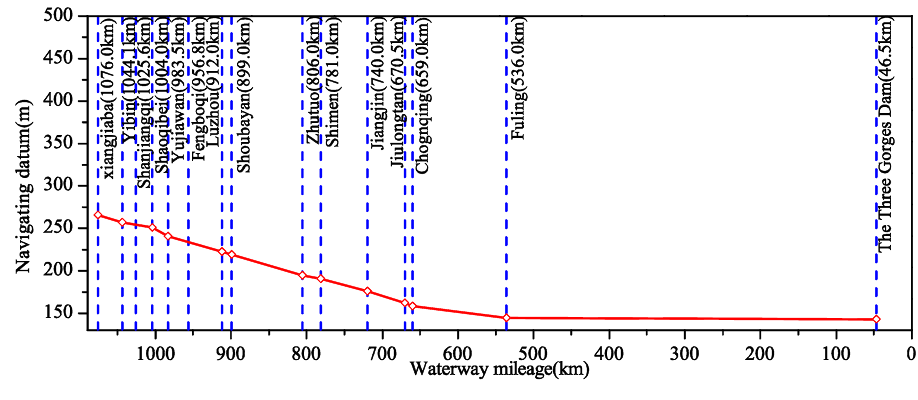
Fig. 2 Schematic diagram of main station waterway